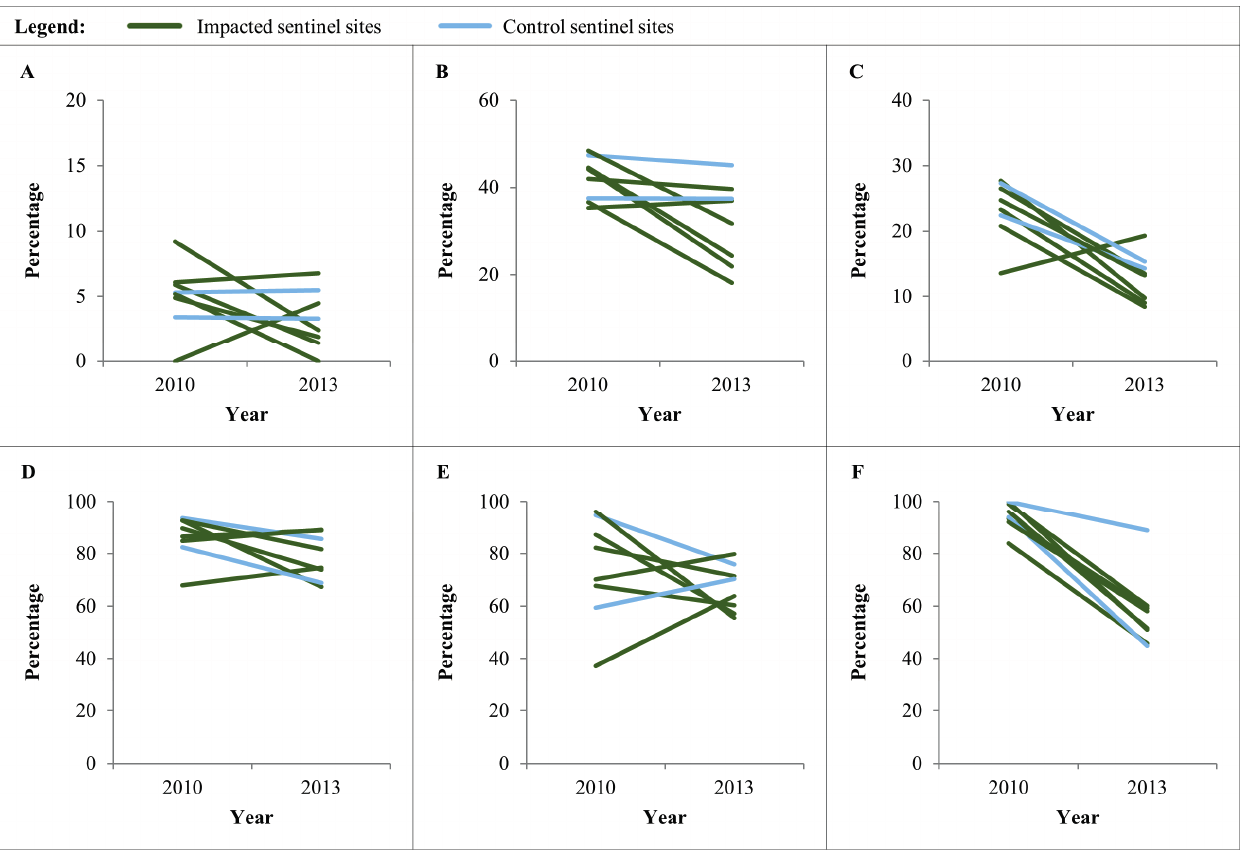
Figure 4. Indicators in children under five years of age in the ABSL study area, stratified by sentinel site, 2010 and 2013. ( A ) Prevalence of wasting (< − 2 SD) in children aged <59 months; ( B ) prevalence of stunting (< − 2 SD) in children aged <59 months; ( C ) prevalence of being underweight (< − 2 SD) in children aged <59 months; ( D ) prevalence of anemia in children aged 6–59 months; ( E ) prevalence of Plasmodium falciparum in children aged 6–59 months; and ( F ) insecticide treated net use in the night preceding the survey in children aged 6–59